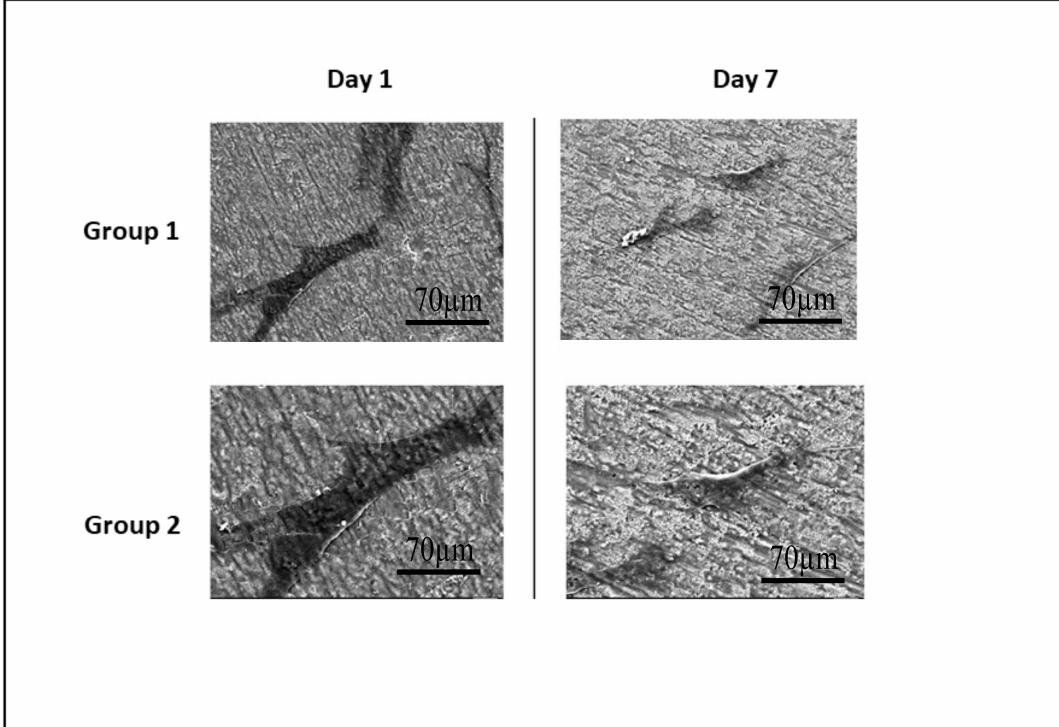
and Group 2 – Nanotubes of TiO 2